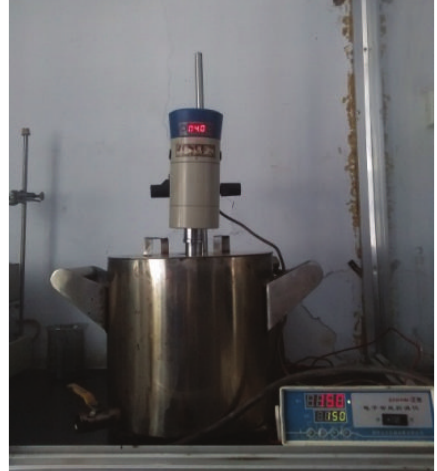
Figure 1: Prepared process of asphalt mastic.